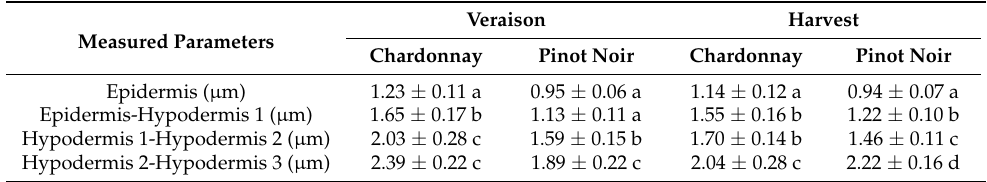
Table 2. Thickness of grape berry skin cell wall layers measured at veraison and harvest. Data represent the means ( ± confidence intervals) of twenty-five measurements performed on Chardonnay and Pinot noir samples. Letters represent the result of a Tukey’s HSD test after one-way ANOVA ( p ≤ 0.05) analysis to find differences between cultivars.